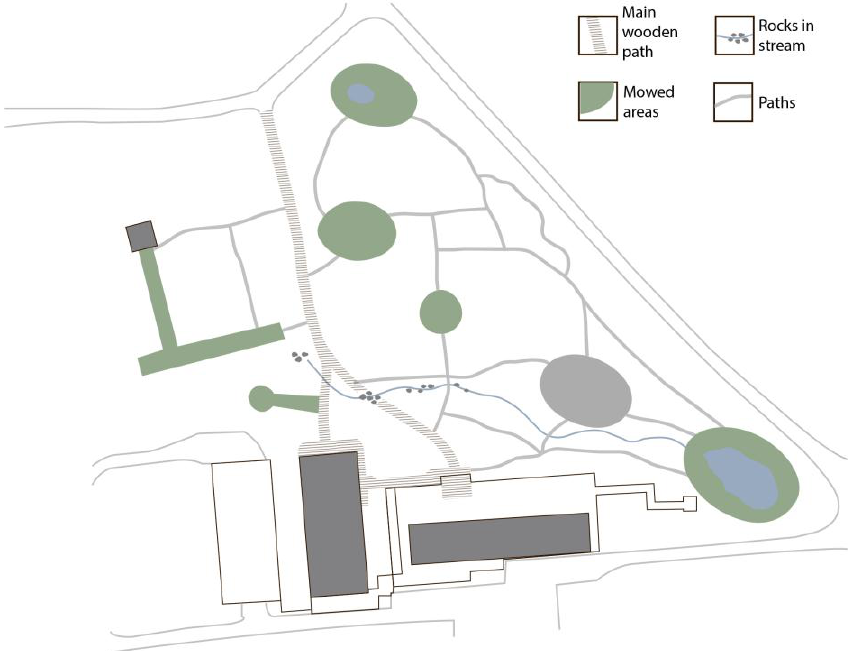
Figure 4. Physical conditions: Components of the terrain.